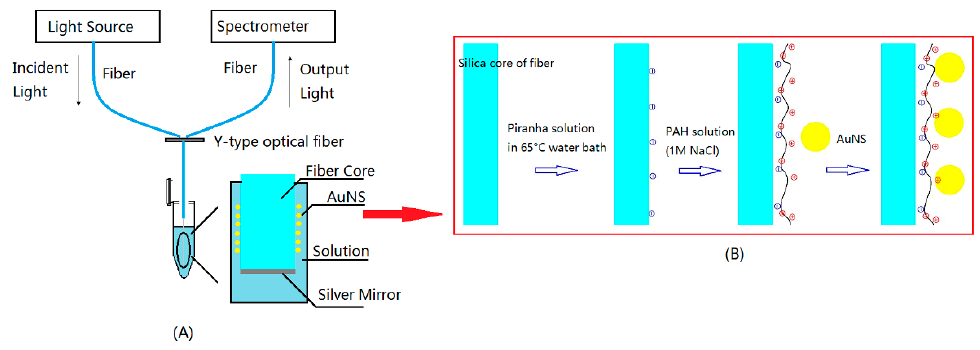
Figure 1. Schematic of ( A ) the fiber sensor design and ( B ) the fabricating processes of AuNS.